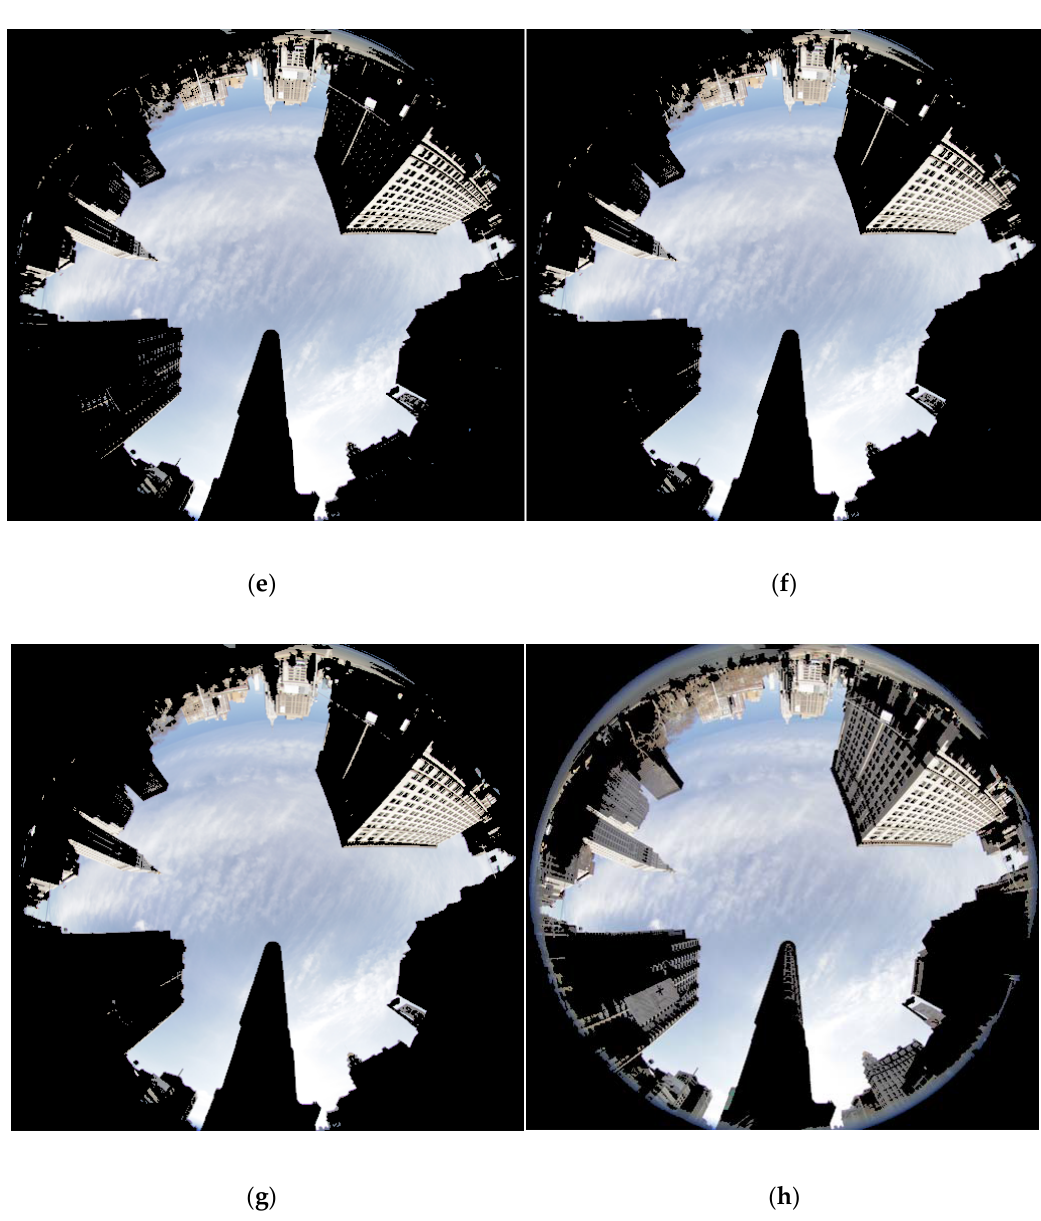
Figure 2. A comparison of the results obtained by applying the simplification filters and the corresponding segmentation methods proposed in [13] and [14] on the image Flatiron fisheye: ( a ) original; ( b ) after simplification filter based on OLS [14]; ( c ) after simplification filter based on LASSO [14]; ( d ) after simplification filter in [13]. Segmentation results into sky/non-sky, obtained on the blue channel: ( e ) without simplification filter, ( f ) with simplification filter based on OLS, ( g ) with simplification filter based on LASSO, ( h ) with simplification filter proposed in [13]. A simple k-means classifier was used. © 2021 IEEE. Reprinted, with permission, from C. Nafornita, C. David and A. Isar, "Preliminary results on sky segmentation," 2015 International Symposium on Signals, Circuits and Systems (ISSCS), 2015, pp. 1–4, doi: 10.1109/ISSCS.2015.7203933.